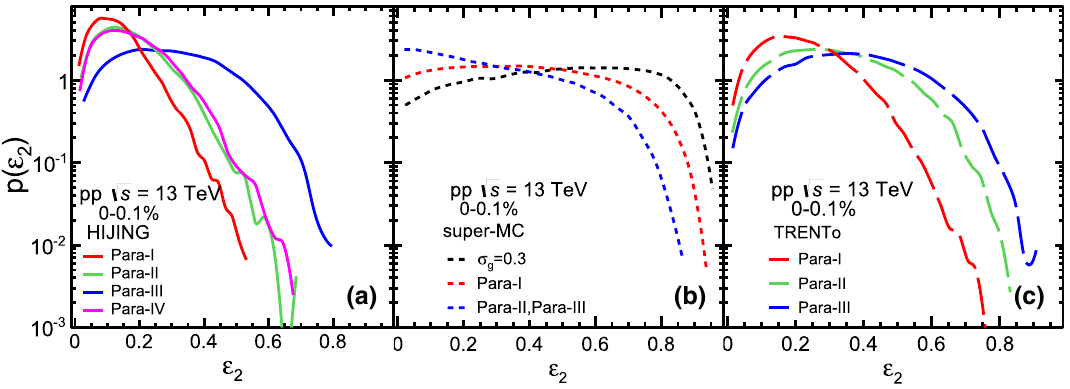
Fig. 4 Event-by-event ε 2 distributions P (ε 2 ) of HIJING ( a ), super-MC ( b ) and TRENTo ( c ) initial conditions at 0–0.1% centrality bin in p–p √ s = 13 TeV collisions at